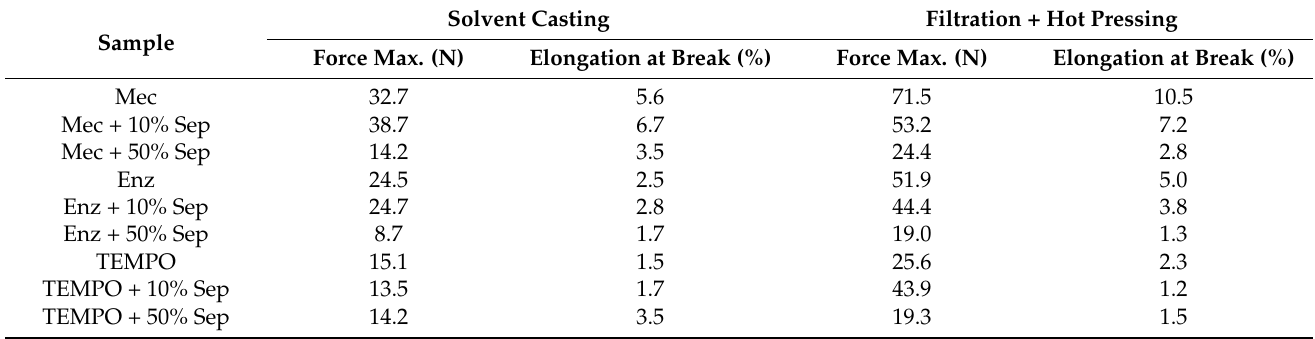
Table A1. Maximum force and elongation at break of the different